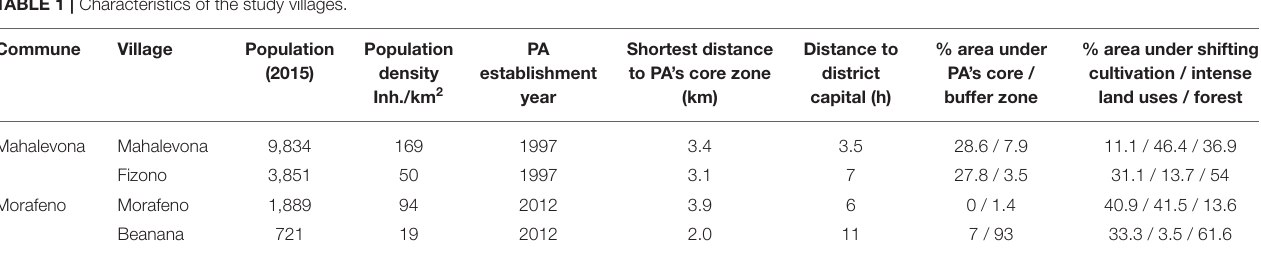
TABLE 1 | Characteristics of the study